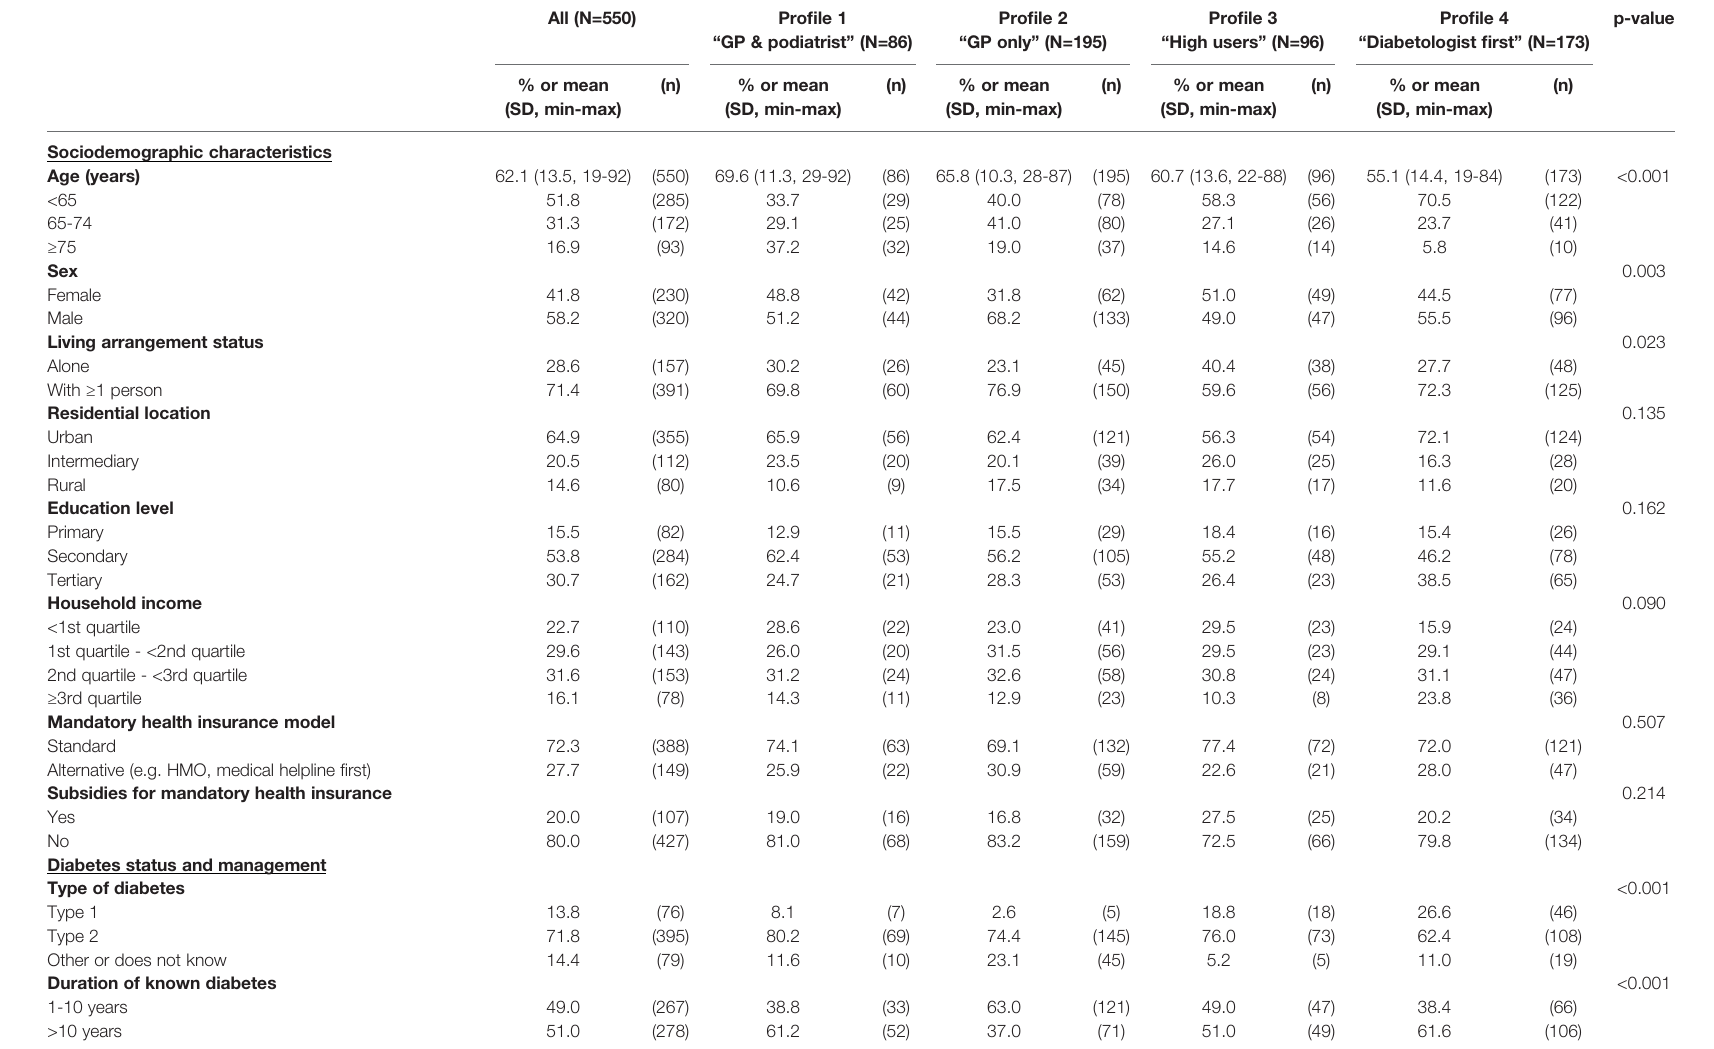
TABLE 1 | Characteristics of participants, by healthcare use pro fi